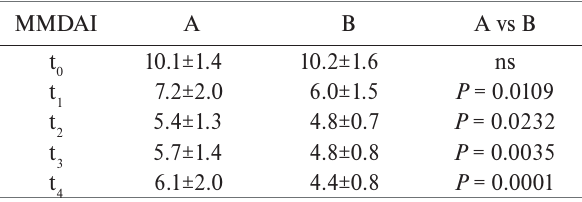
Table 2. modified mayo disease activity index (mmdai) from t to t , in group a, B and a vs B. 0 4